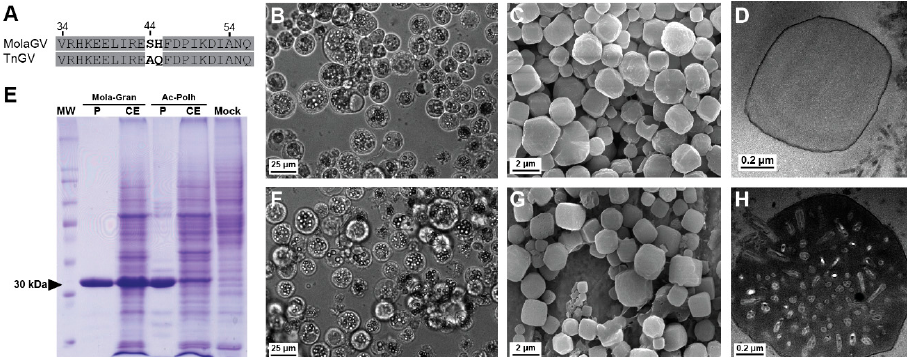
Figure 6. Characterization of the MolaGV granulin gene using a recombinant Autographa californica multiple nucleopolyhedrovirus (AcMNPV). ( A ) Specific region of the Granulin from both MolaGV and TnGV presenting the amino acid differences between the proteins; ( B , F ) SF-21 cells were infected for 72 h (Multiplicity of Infection, MOI, of 10) with either the MolaGV- granulin -expressing virus ( B ) or the AcMNPV- polyhedrin -expressing virus ( F ). The viruses produced crystals during infection and the crystals localized into the nuclei; ( C , G ) MolaGV-Granulin and AcMNPV-Polyhedrin crystals were similar in shape by SEM; ( D ) MolaGV-Granulin crystals were empty whereas ( H ) AcMNPV-Polyhedrin crystals presented embeded virions; ( E ) The crystals were also analyzed by SDS-PAGE and the head arrow points both the granulin and the polyhedrin band. Lane MW: protein marker; lane P: purified OBs: CE: virus-infected cell extracts. Mock: mock-infected